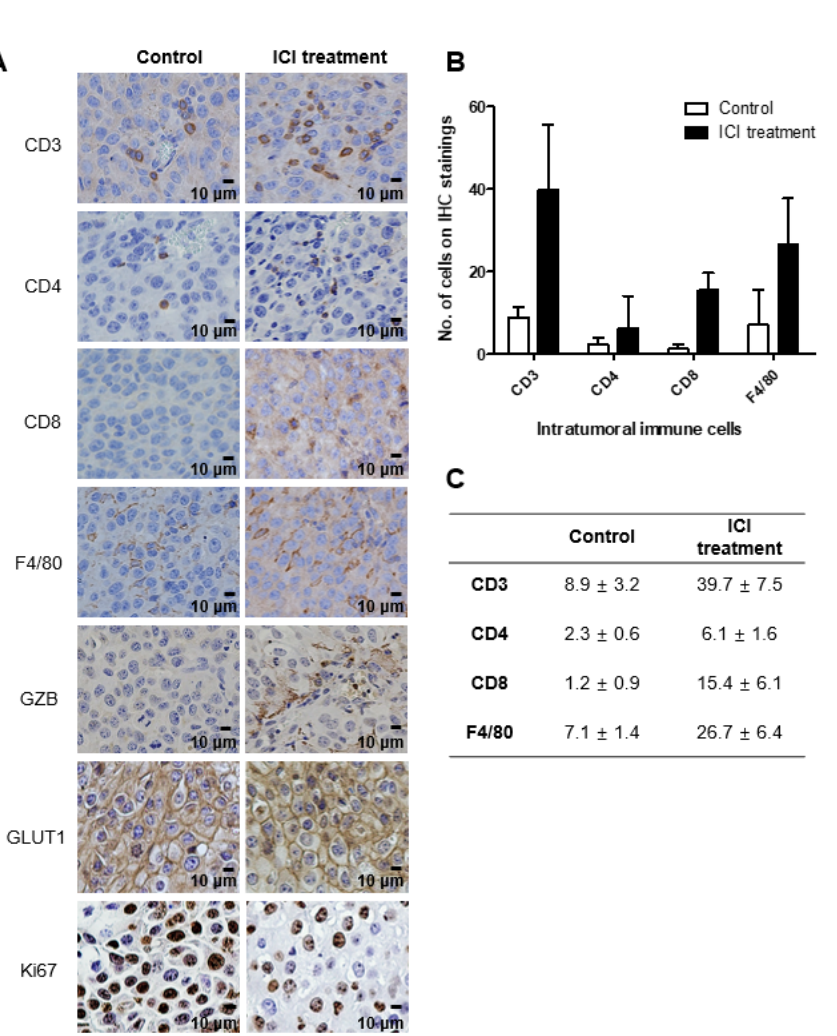
Figure 5. Histological analysis after ICI treatment. Intra-tumor infiltration of immune cells were observed in the ICI-treated group at Day 10. ( A ) Pan-T (CD3+), helper T cells (CD4+), cytotoxic T cells (CD8+), macrophages (F4/80+), granzyme B (GZB), glucose transporter (Glut-1), and cell proliferation (Ki-67) markers were stained. ( B ) The number of various immune cells infiltrated in the tumor tissue. ( C ) The number of intra ‐ tumoral immune cells on IHC samples.